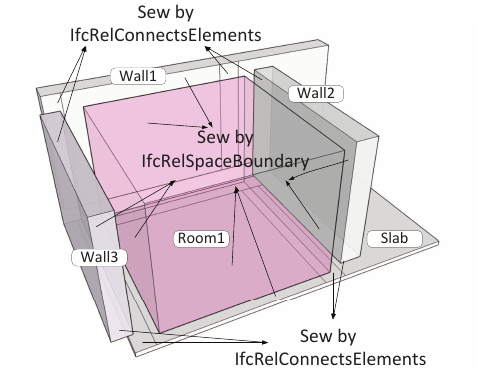
Figure 7. Sew 3-cells by IFC relationships